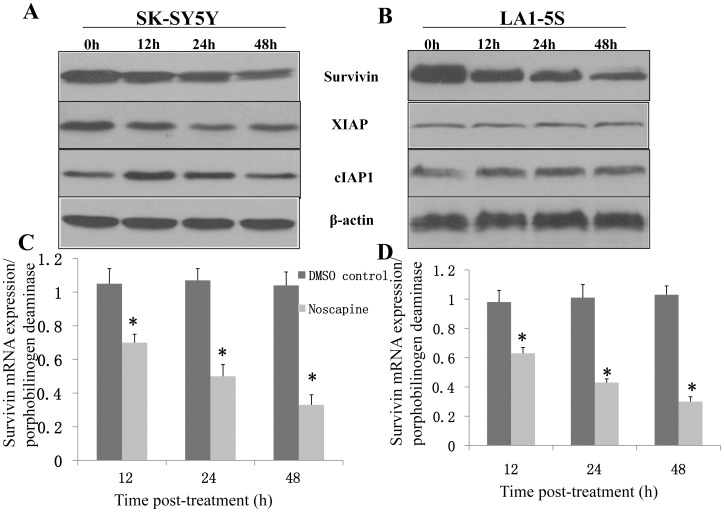
Noscapine selectively cause survivin downregulation in SK-SY5Y and LA1-5S cells.Immunoblotting for survivin, cIAP1and XIAP using lysates from SK-SY5Y(A) and LA1-5S (B) cells treated with DMSO (control) or Noscapine (50 µmol/L) for the indicated time periods. Immunoblotting for each protein was done at least twice using independently prepared lysates. Representative data from one such experiment are shown. Histograms represent the increase or decrease of survivin mRNA expression in SK-SY5Y (C) and LA1-5S (D) cells incubated with noscapine (50 µM/mL) for 12, 24, and 48h. Measurements were performed in triplicate. Bars represent standard errors and asterisks designate statistically significant results (P<0.05).